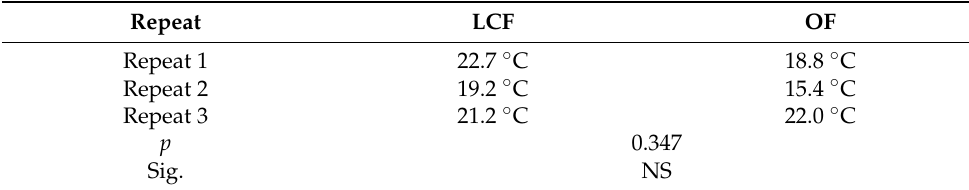
Table 8. Effects of light conversion film (LCF) and ordinary film (OF) on leaf canopy temperature at heading stage. Repeat LCF OF Repeat 1 22.7 ◦ C Repeat 2 Repeat 3 p 0.347 Sig.